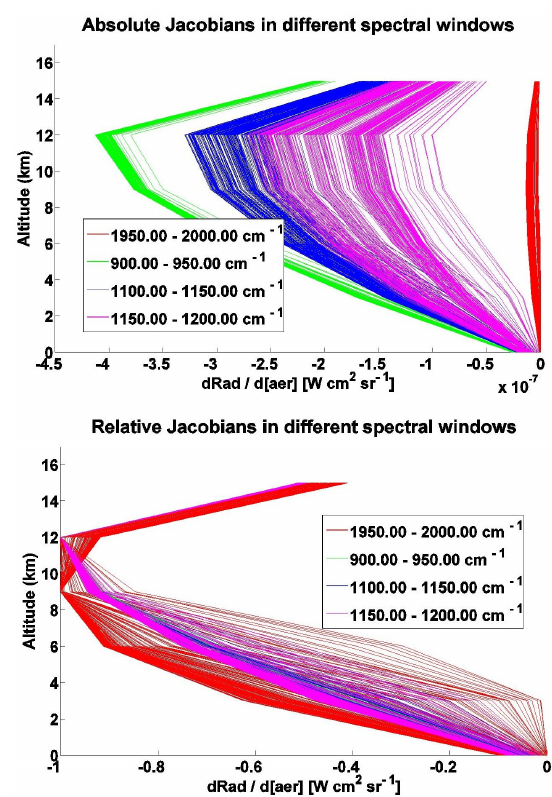
Figure 3. Ash aerosol weighting functions or Jacobians for the spectral windows listed in the figure legend, in absolute values (upper panel) and in relative values (lower panel; all Jacobians were scaled to the maximum absolute value of 1). The aerosol vertical distribution was 50 particles/cm 3 from a 0- to 18-km altitude, leading to a 10 µ m AOD of